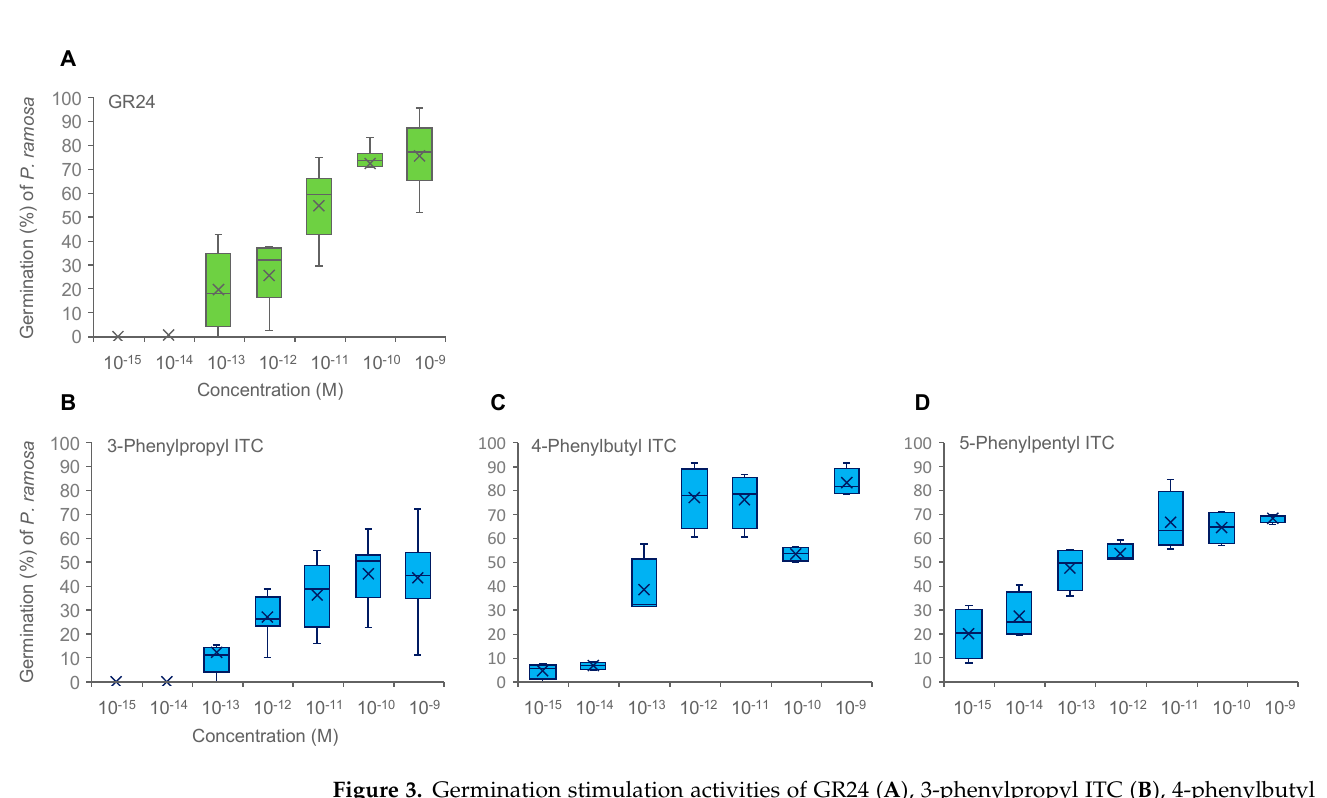
Figure 3. Germination stimulation activities of GR24 ( A ), 3-phenylpropyl ITC ( B ), 4-phenylbutyl ITC ( C ), and 5-phenylpentyl ITC ( D ) on P. ramosa at lower concentrations. The box represents the interquartile range, whiskers represent the maximum and minimum values, the middle indicates the median, and the x within the box represents the mean ( n = 6).